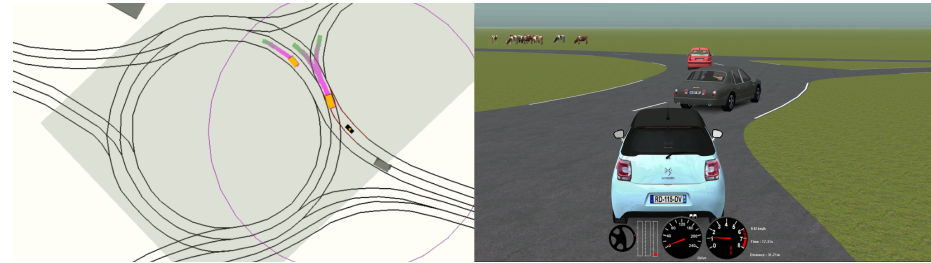
Figure 5. Combined predictions grids for two vehicles in a time horizon of 4